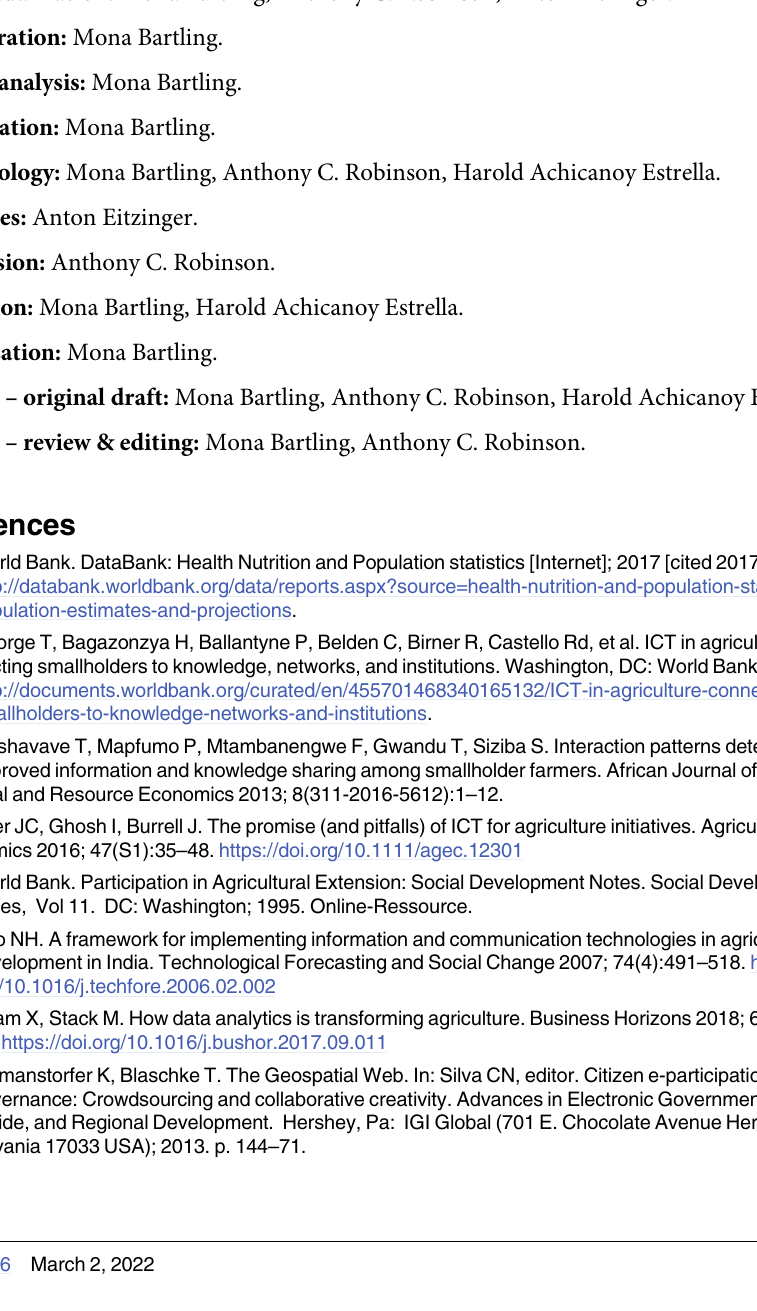
S6 Table. Odds ratio and confidence intervals for regression model of Table 6 with confi- dence ratings as dependent